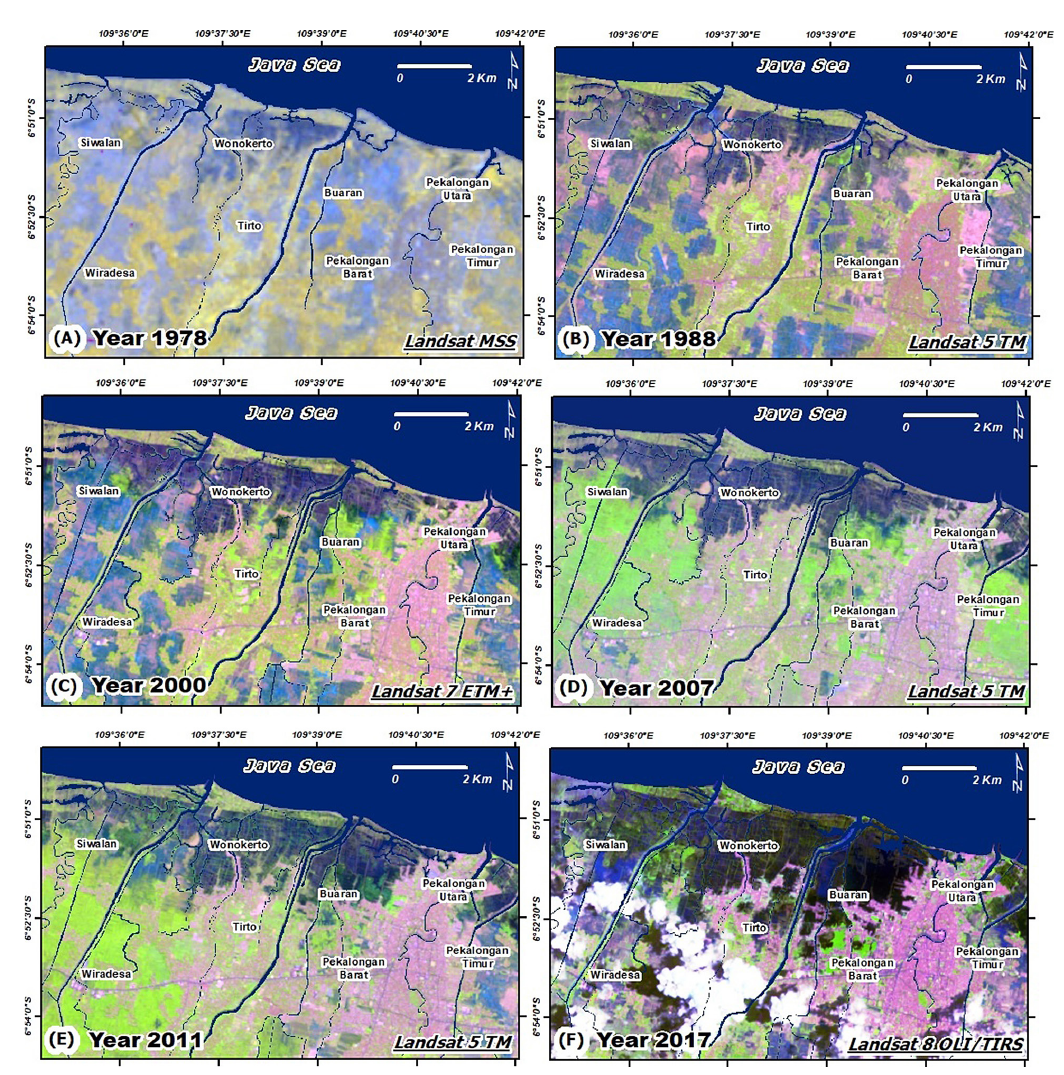
Fig. 2. Landsat images were used to perform coastal landform mapping, consisting of analysis of multi- temporal changes in morphology for 1978 to 2017 in the study area.